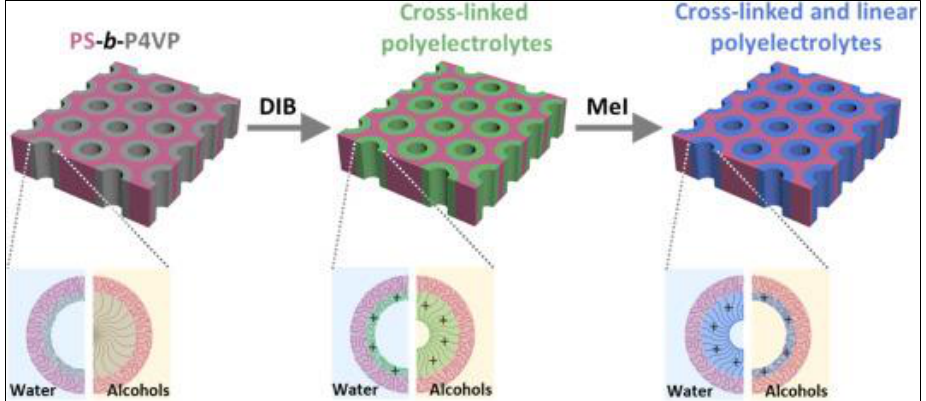
Figure 9. Self-assembled membranes from BCP. Schematic representation of nanostructured mem- branes enabled by BCP and their stimuli-responsive adaptation for filtration membranes. Microphase separation of PS- b -P4VP yields pores of P4VP that can be post-functionalized by 1,4-diiodobutane (DIB) and methyl iodide (MeI), controlling their hydrophilicity. Reproduced with permission from the original article [207].